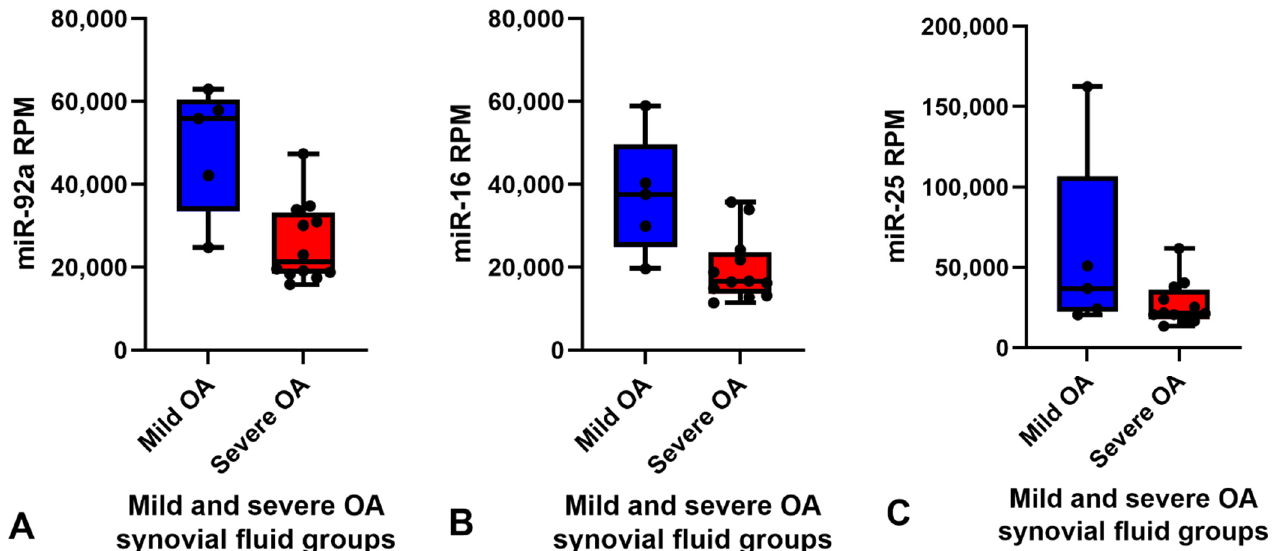
Figure 3. Box and whisker plots showing the RPM of each miRNA for each sample in the mild (blue) ( n = 5) and severe (red) ( n = 12) OA groups. Boxes show minimum RPM, median with interquartile range and maximum RPM. Significantly downregulated miRNAs in the severe OA synovial fluid group compared to mild OA group ordered by logFC (FDR < 0.1) ( A ) miR-92a, ( B ) miR-16 and ( C ) miR-25 calculated using edgeR’s glmQLFTest method. Reads per million (RPM), log fold change (LogFC), false discovery rate (FDR) and osteoarthritis (OA).